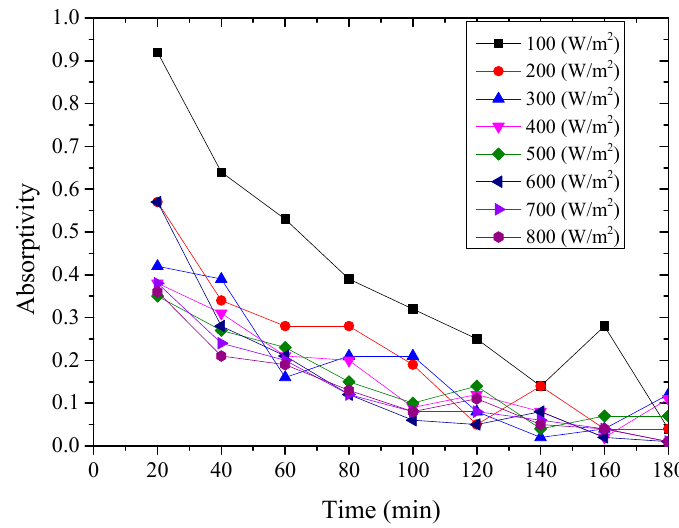
Figure 9. Variation of the instantaneous absorptivity for the nanoporous alumina sheet with 30 nm pore diameter.